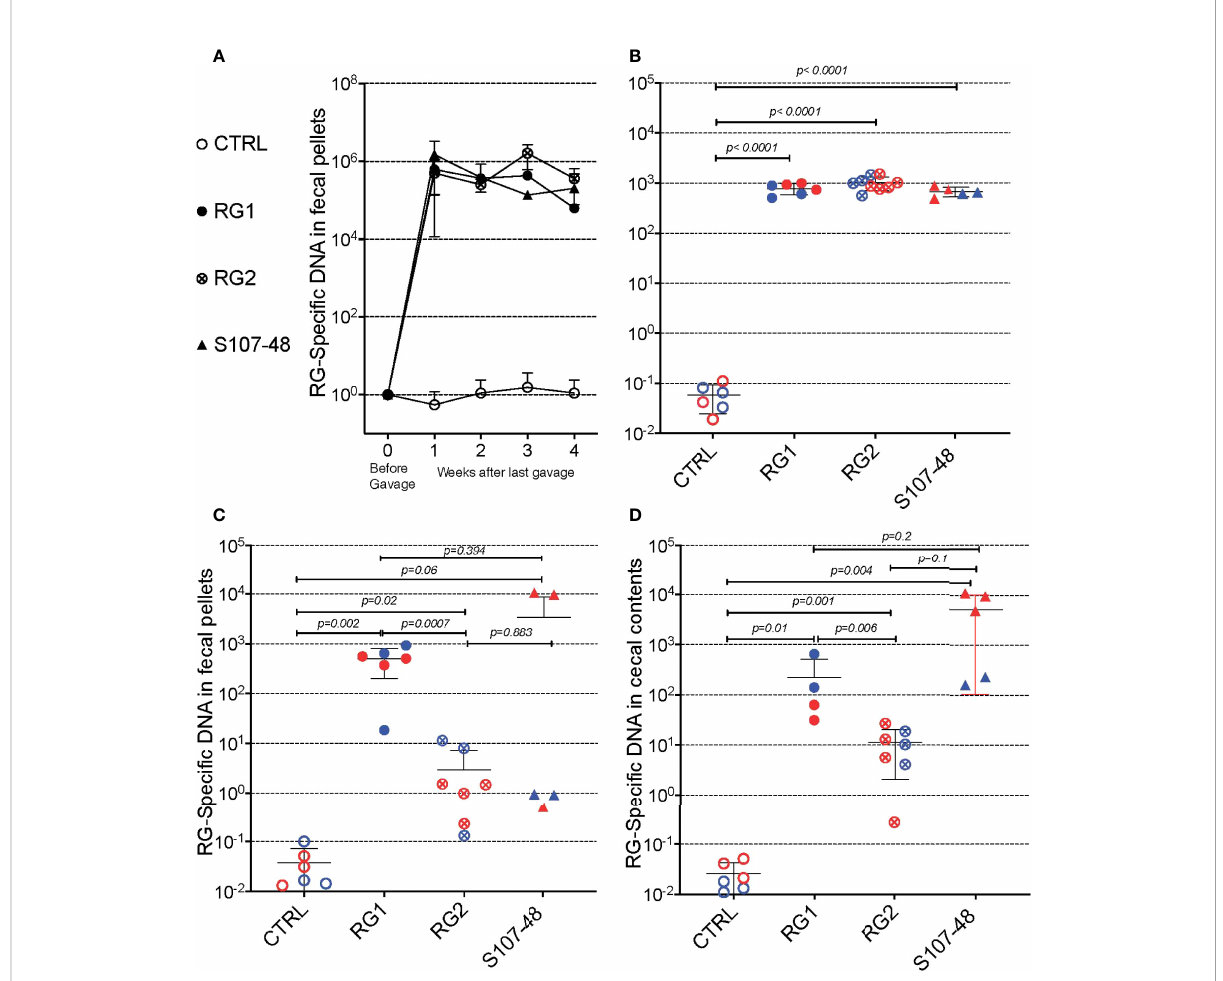
FIGURE 2 Diverse RG strains isolated from human donors colonize germ-free (GF) mice, and are passed to their litters. (A) Abundance of RG DNA in germ-free (GF) C57BL/6 mice breeding pairs, monocolonized by oral gavage with RG1, RG2 or S107-48 RG strains. RG species-speci fi c 16S rRNA genomic levels were quanti fi ed by genomic qPCR analysis of fecal pellets, as shown. Inset values indicate normalized quantity of RG 16S rDNA with control mice, before (left) and weeks after (right) gavage with each of the RG stains, as indicated. (B) Abundance of RG-speci fi c genomic DNA in 4wk-old litters of the RG1, RG2 and S107-48-monocolonized GF breeding pairs. RG species-speci fi c 16S rRNA levels were quanti fi ed by genomic qPCR analysis of fecal pellets, as shown. (C) Abundance of RG DNA in fecal pellets of 12-14wks-old litters of the individual RG1, RG2 and S107-48 strains monocolonized GF breeding pairs. (D) Abundance of RG DNA in cecal pellets of 12-14 wk-old litters of RG1, RG2 and S107-48-monocolonized GF breeding pairs. Note that overtime there is increased variability of RG strain persistence as measured in fecal pellets, but less heterogeneity in RG representation in the luminal extracts of the cecums of these same individual colonized mice. (Red) indicates female and (Blue) male mice are indicated